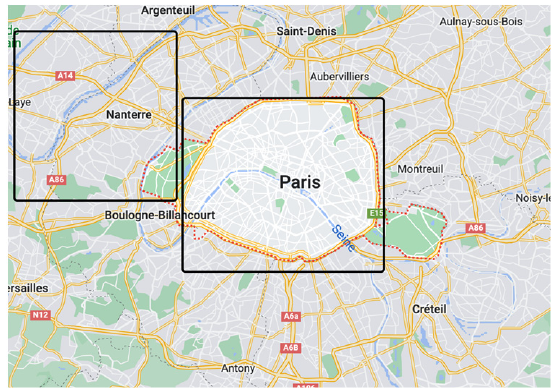
Figure 4. Privacy protection zones: city of Paris and Nanterre district.